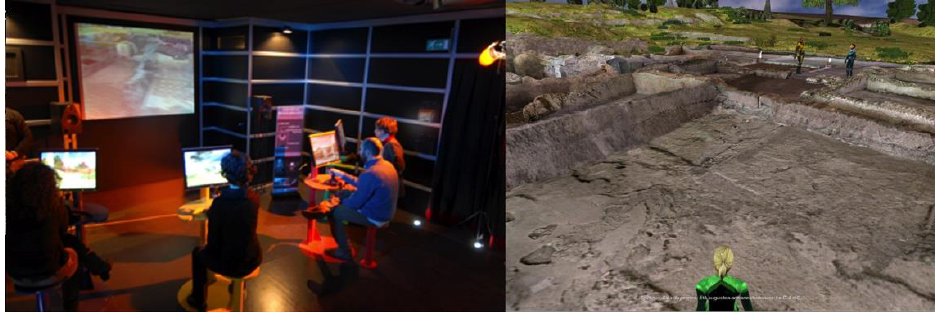
Figure 9. Virtual Museum of Ancient Via Flaminia , VR multi-user domain in a museum installation, National Roman Museum of Diocletian’ Bath. Realized by CNR ITABC in 2007– 2008.